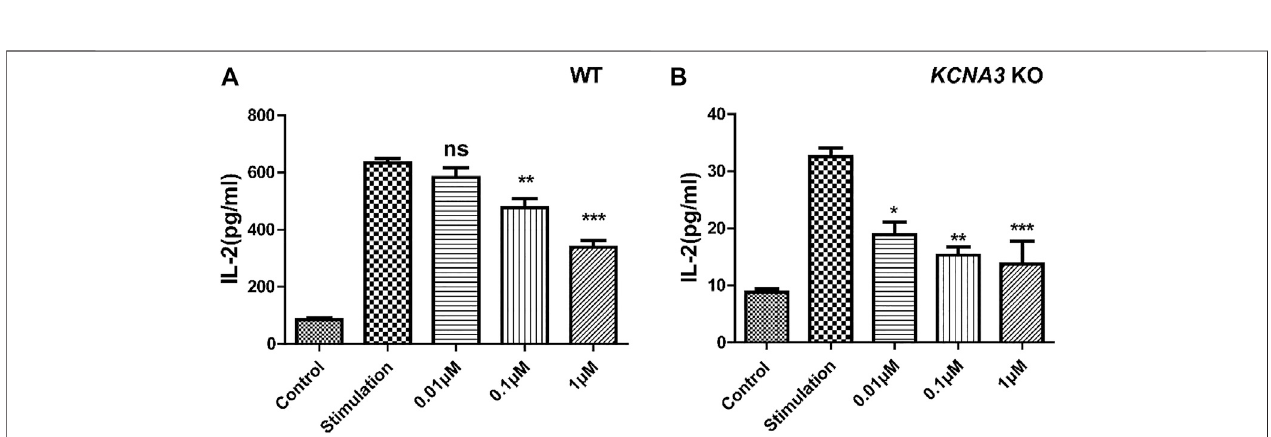
FIGURE2| Effects ofKv1.3 KO onIL-2 secretion. (A) ChangesofIL-2 secretion inwild type Jurkat Tcells under control, ConA stimulation,and LrB treatment with different concentrations ( n (cid:2) 5); (B) Changes of IL-2 secretion in the Kv1.3 KO Jurkat T cells under control, ConA stimulation, and LrB treatment with different concentrations ( n (cid:2) 5). Data were presented as mean ± SEM. Statistical analysis of differences between groups was carried out using one-way ANOVA combined with Turkey ’ s post-hoc test. ***, p < 0.001.